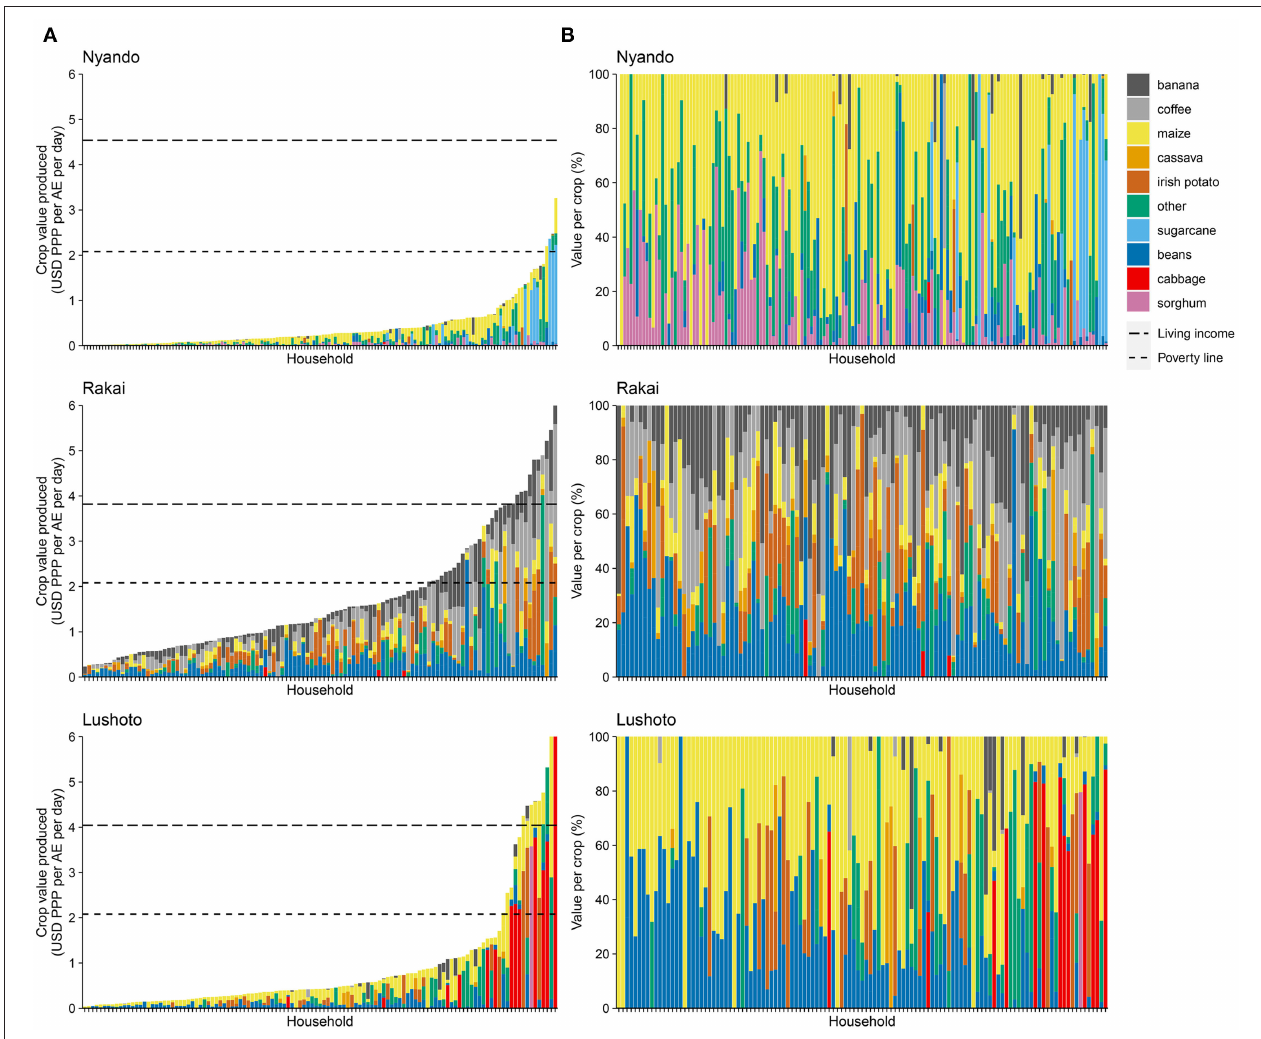
FIGURE 3 | The current value of crop produce in relation to the poverty line and living income benchmarks (A) and the relative contribution of different crops to the total value of crops (B) . The value of crop produce is the sum of the value sold, consumed and fed to livestock. Households in (B) are ordered the same as in (A)